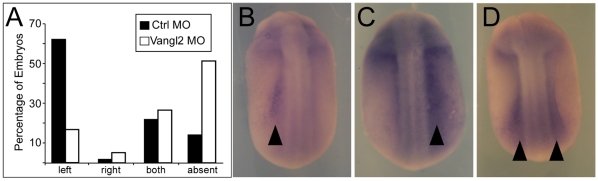
Vangl2 MO knockdown disrupts left-right patterning.(A) Xenopus embryos were injected with Vangl2 MO, or Control MO alone, targeting one dorsal blastomere at the 8-cell stage to generate a clone of injected cells within the GRP. At stages 20/21, embryos were fixed and probed by in-situ hybridization with an antisense Xenopus nodal-related1 (Xnr1) probe. Sidedness of staining was scored for at least 60 embryos for each condition. Data from one experiment are shown. (B–D) Shown are embryos injected with either Vangl2 or Control MOs and then probed with Xnr1 in-situ probe. Xnr1 staining is evident on the left (B) right (C) or both (D) sides of the midline. Black arrowheads indicate staining.